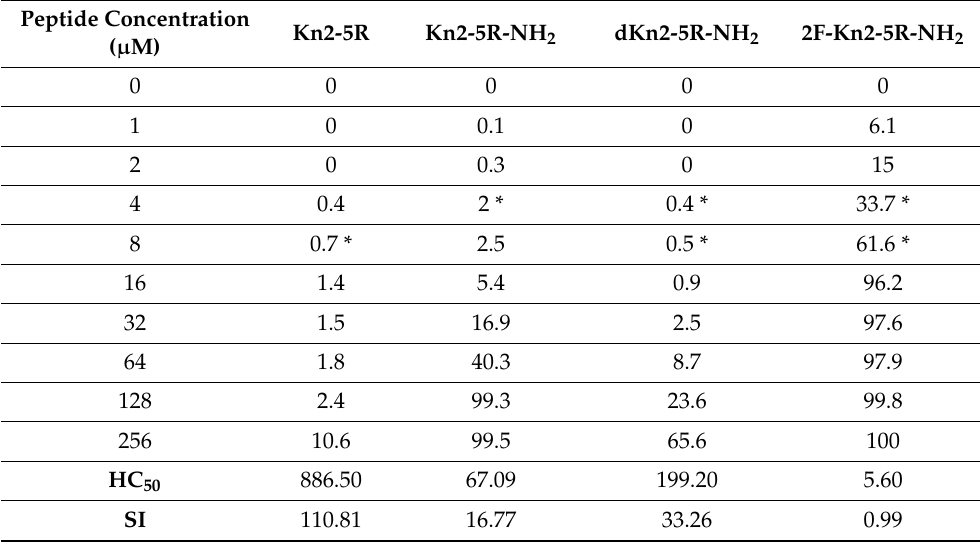
Table 4. Hemolytic activity of the variant peptides on sheep red blood cells shown in percent hemolysis and their SI toward Salmonella . Peptide Concentration Kn2-5R Kn2-5R-NH 2 dKn2-5R-NH 2 2F-Kn2-5R-NH 2 ( µ M) 0 0 0 0 0 1 0 0.1 0